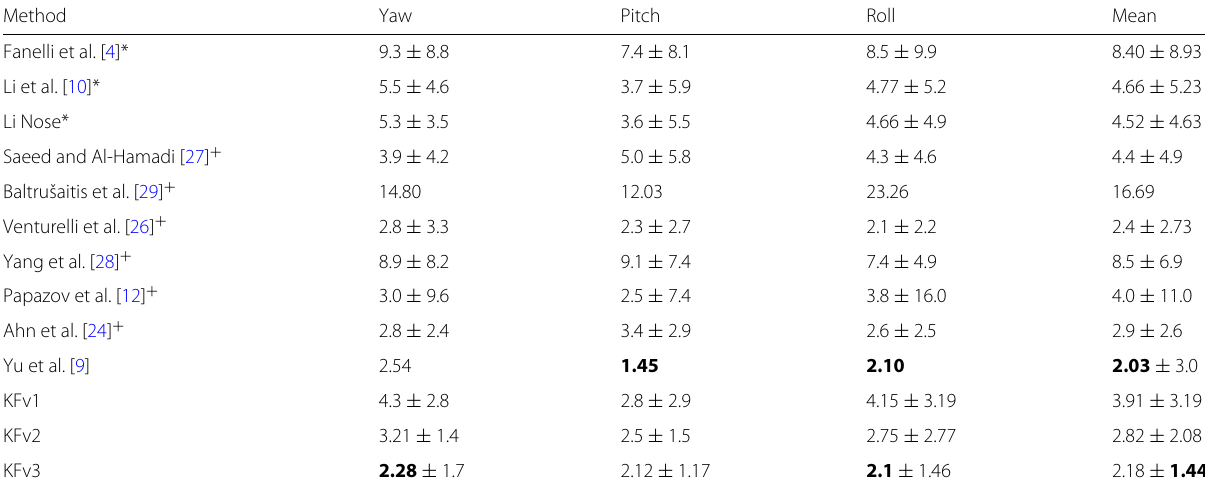
Table 3 Results on BIWI dataset in Euler angles Method